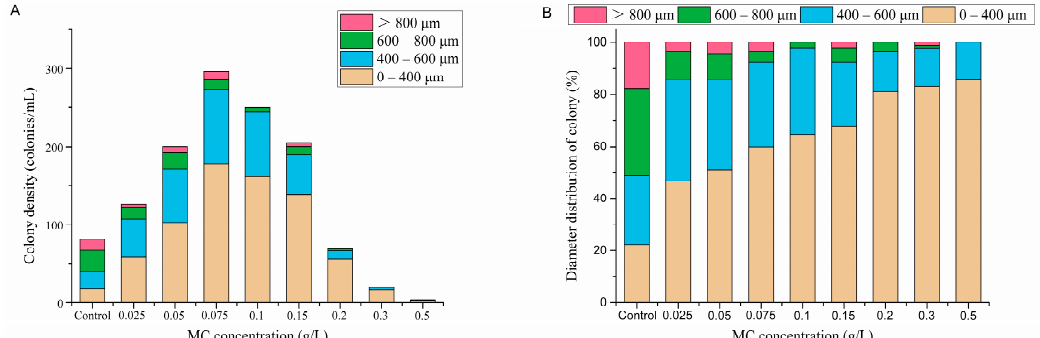
Figure 6. ( A ) Density and ( B ) percentage of the colonies in different ranges divided by colony diameter on the 10th day after MC addition.